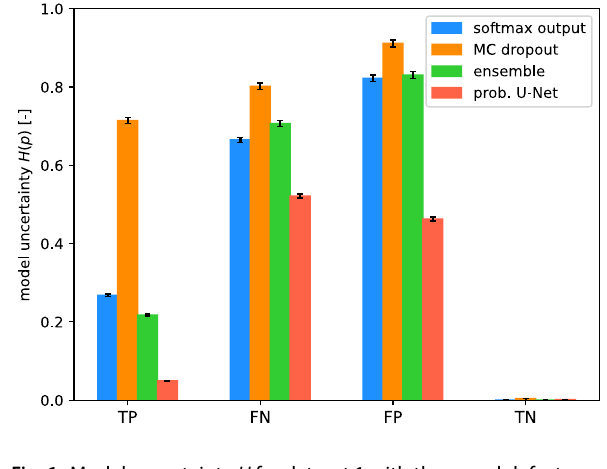
Fig. 6 Model uncertainty H for dataset 1 with the round defects